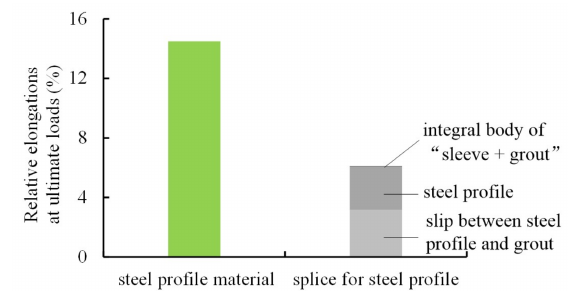
Figure 12. Comparison of deformation contribution within gauge length of Specimen RT350 at ultimate